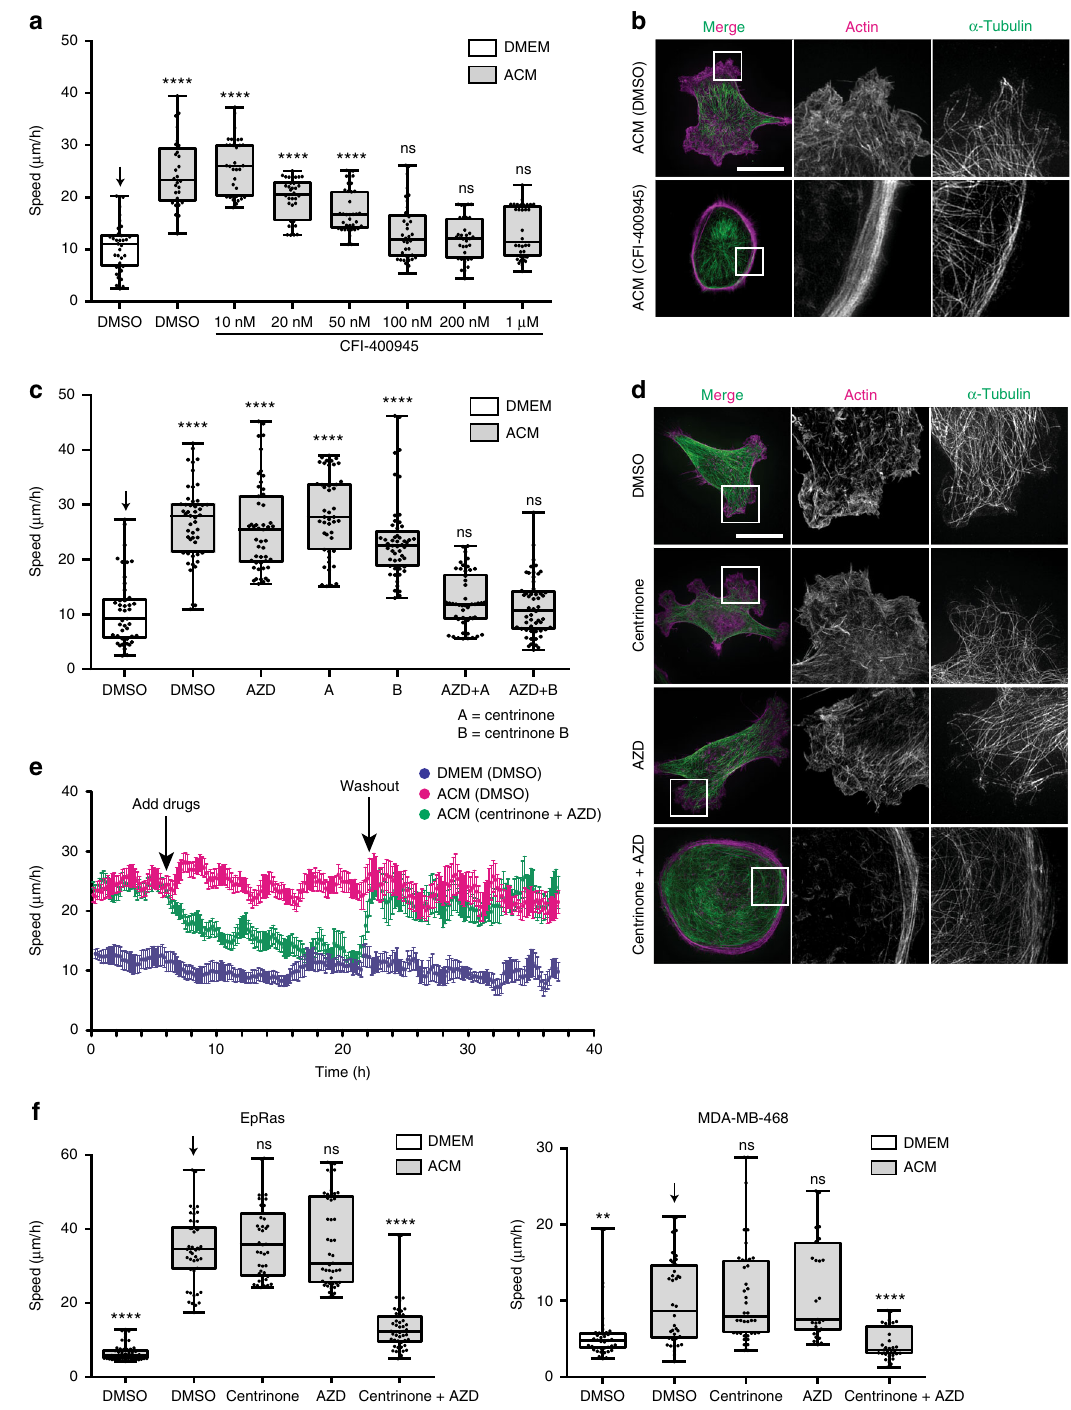
Fig. 3 PLK4 and AURKB/C redundantly modulate ACM-induced cancer cell motility. a MDA-MB-231 cells were treated with DMSO or different concentrations of CFI-400945 (PLK4 and AURKB/C inhibitor), in the presence of DMEM or ACM (**** p <0.0001; n = 3, at least 50 cells were tracked per condition). b MDA- MB-231 cells were treated with DMSO or 100nM CFI-400945 in the presence of ACM stimulation. Cells were stained for α -tubulin and actin, and enlarged images showed a cortical region of the cell. Bar = 20 µ m ( n = 3). c MDA-MB-231 cells were treated with centrinone, centrinone B (PLK4 inhibitors), AZD (AURKB/C inhibitor) or their combination, in the presence of DMEM or ACM overnight (*** p <0.0001; n = 3, at least 50 cells were tracked per condition). d Cells from ( c ) were stained for α -tubulin and actin, and cortical regions were enlarged on right side panels. Bar = 20 µ m. e Cells were incubated with DMEM or ACM overnight. At 6h of taking time-lapse images, DMSO or inhibitors were added to cells and incubation continued for 14h more, then DMSO or inhibitors were washed out and cells were further incubated in DMEM or ACM for another 16h. Running average speed was plotted as mean±s.e.m. ( n = 4, at least 50 cells were tracked per condition) f Breast cancer cell lines EpRas and MDA-MB-468 were treated with DMEM or ACM in the presence of DMSO or inhibitors (** p <0.01, **** p <0.0001; n = 3, at least 40 cells were tracked per condition). All the data were plotted as box and whiskers. Boxes represent median and 25th to 75th percentiles, whiskers the minimum and maximum values with each individual cell value superimposed. The data were compared with one-way ANOVA Kruskal – Wallis test and post-tested with Dunn ’ s multiple comparison test. Arrow indicates the control bar used for